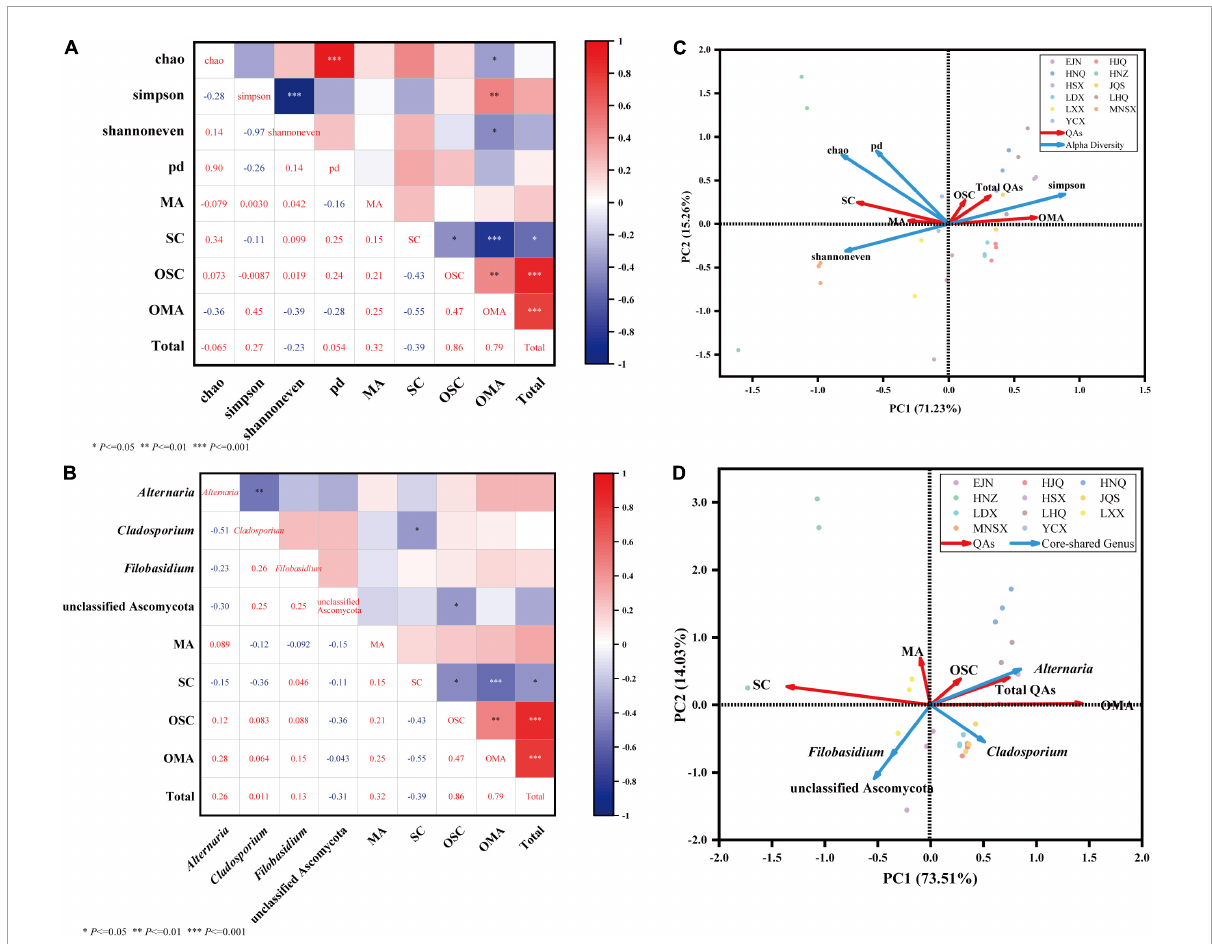
FIGURE5 Community diversity of endophytic fungi in seeds of S. alopecuroides and correlation analysis of core-shared genera and bioactive compounds. Sections (A,C) are heatmaps of Spearman correlation analysis of endophytic fungal diversity and core-shared genera and host bioactive compounds, respectively. * Means P < 0.05, ** means P < 0.01, *** means P < 0.001. Sections (B,D) are the redundancy analysis of endophytic fungal diversity and host bioactive compounds, respectively, blue represents the alpha diversity index and core genus fungi, red represents four bioactive compounds, different colored dots represent samples, and sharp angles represent positive correlations, the obtuse angle indicates negative correlation.